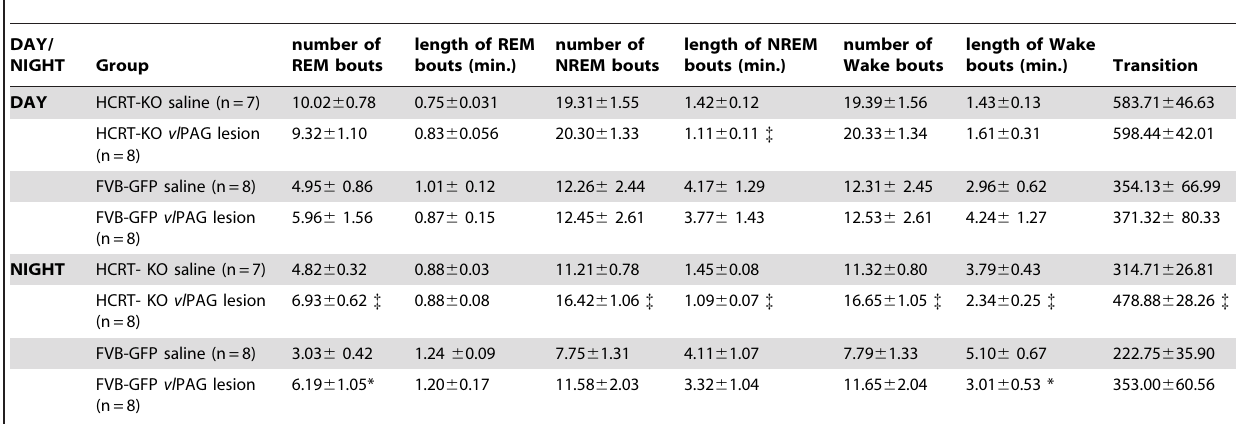
Table 1. Effect of the HCRT-SAP induced lesions on the average ( 6 SEM) number and length of bouts of wake, non-REM and REM sleep.